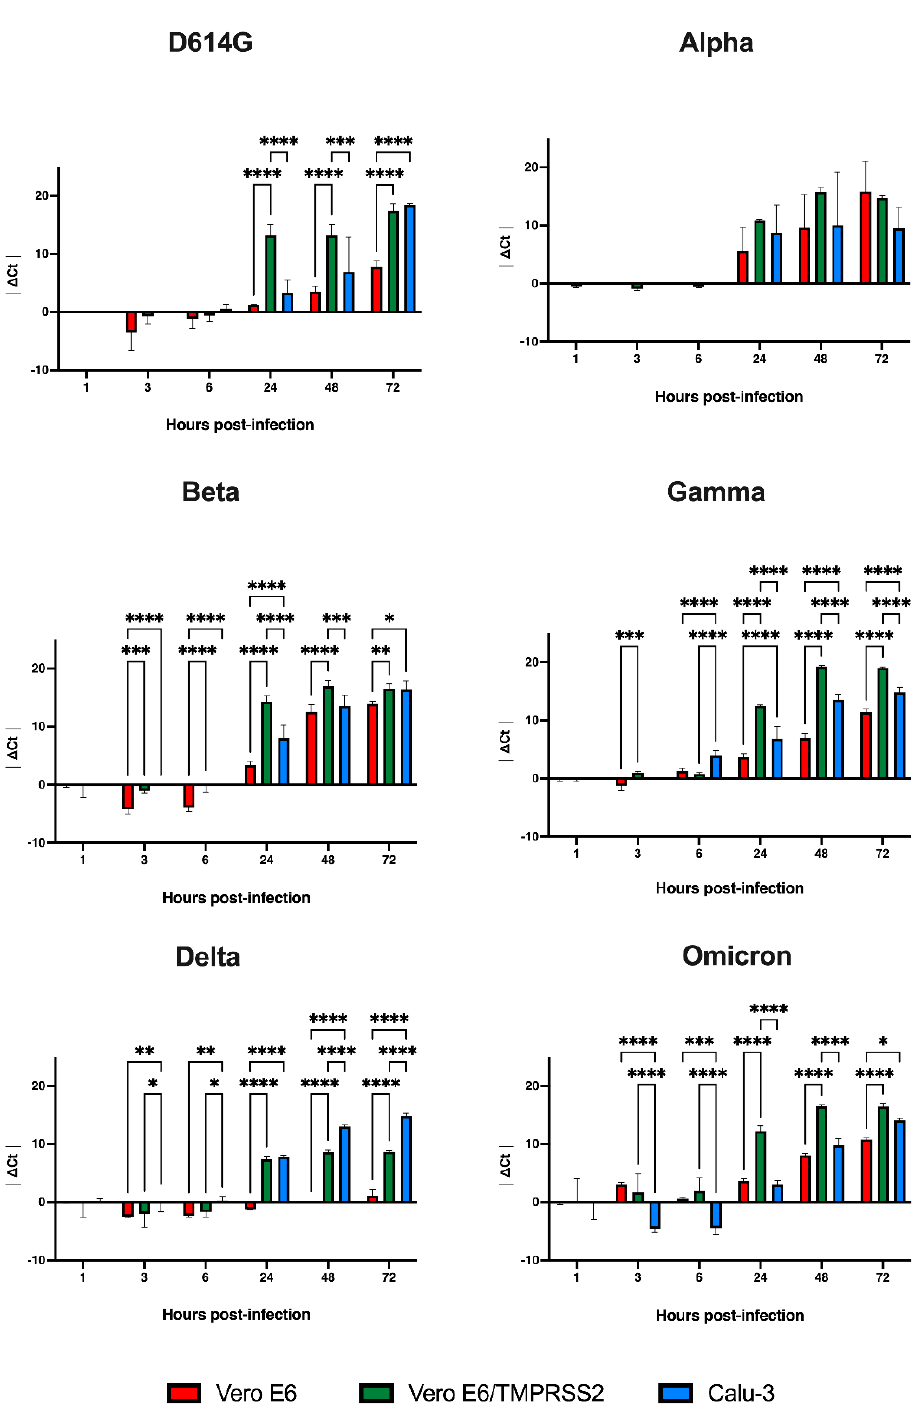
Figure 2. SARS-CoV-2 replication in the different cell lines. Growth curves showing the release of viral genome into the medium of cells incubated for 1 h with viruses at 0.001 MOI: D614G, Alpha, Beta, Delta and Omicron variants. The Δ Ct were reported as the mean values ± SD, * p < 0.05, ** p < 0.01, *** p < 0.001 and **** p < 0.0001. Ct: threshold cycle. The replication of Beta, Delta and Omicron variants in Calu-3 was different from the other two cell lines starting from 3 hpi (Beta: p < 0.0001 vs. Vero E6 and p < 0.001